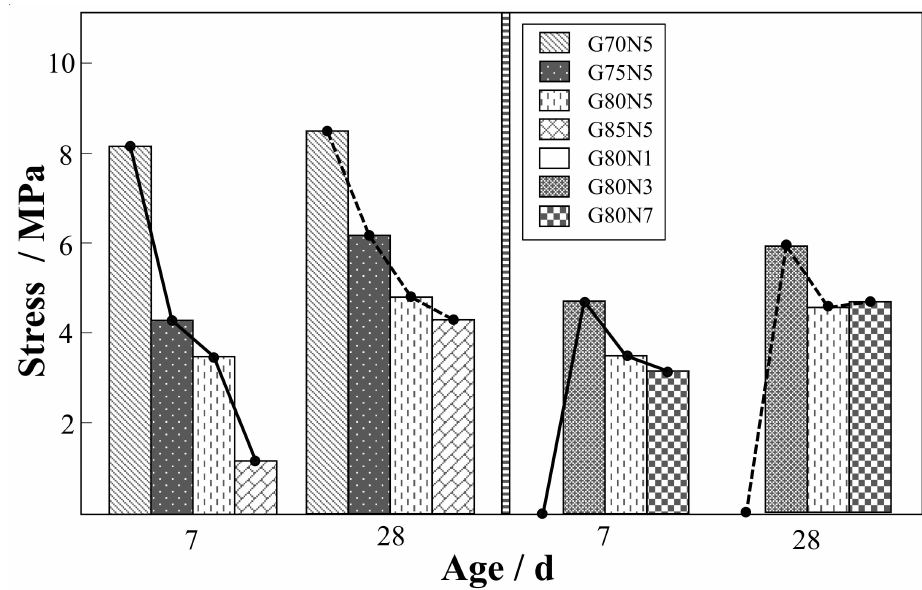
Figure 3. Influence of different alkali contents and aggregate ratios on the compressive strength of the tested block.